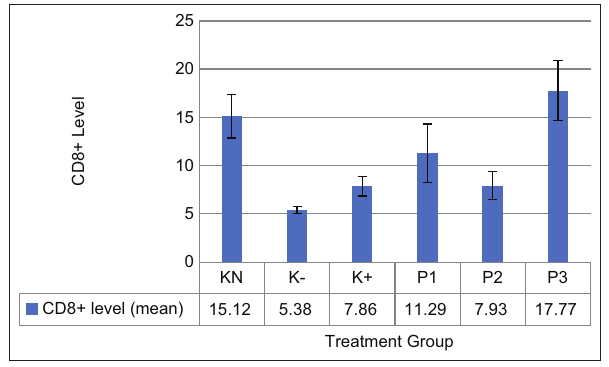
Figure-3: Effect of ethanolic extract of red okra pods on the level of CD8+ T cell activity. KN=Normal control, K−=Negative control, K+=Positive control. P1, P2, and P3=Administrated with 50, 100, and 200 mg/kg body weight ethanolic extract of red okra pods. Each bar represents means±standard deviation (n=5). *p<0.05 compared to the negative control. **p<0.05 compared to all groups.